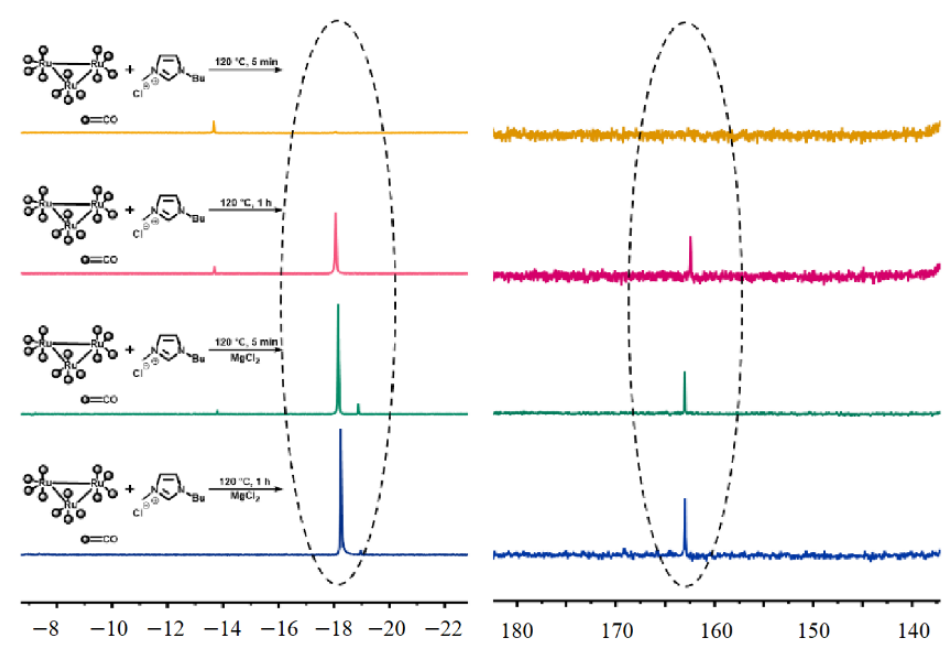
Figure 2. 1 H (400 MHz, CDCl 3 ) NMR and 13 C (100 MHz, CDCl 3 ) NMR partial spectra of the species formed by reacting Ru 3 (CO) 12 with [Bmim]Cl. Reaction condition: Ru 3 (CO) 12 (0.2 mmol), [Bmim]Cl (3.2 mmol), 120 ◦ C. Table 2. Hydroesterification reaction performed under various catalytic species a .